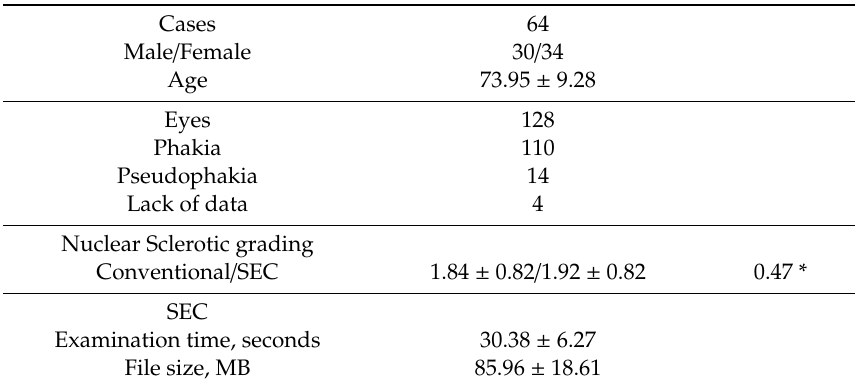
Table 1. Demographic of the